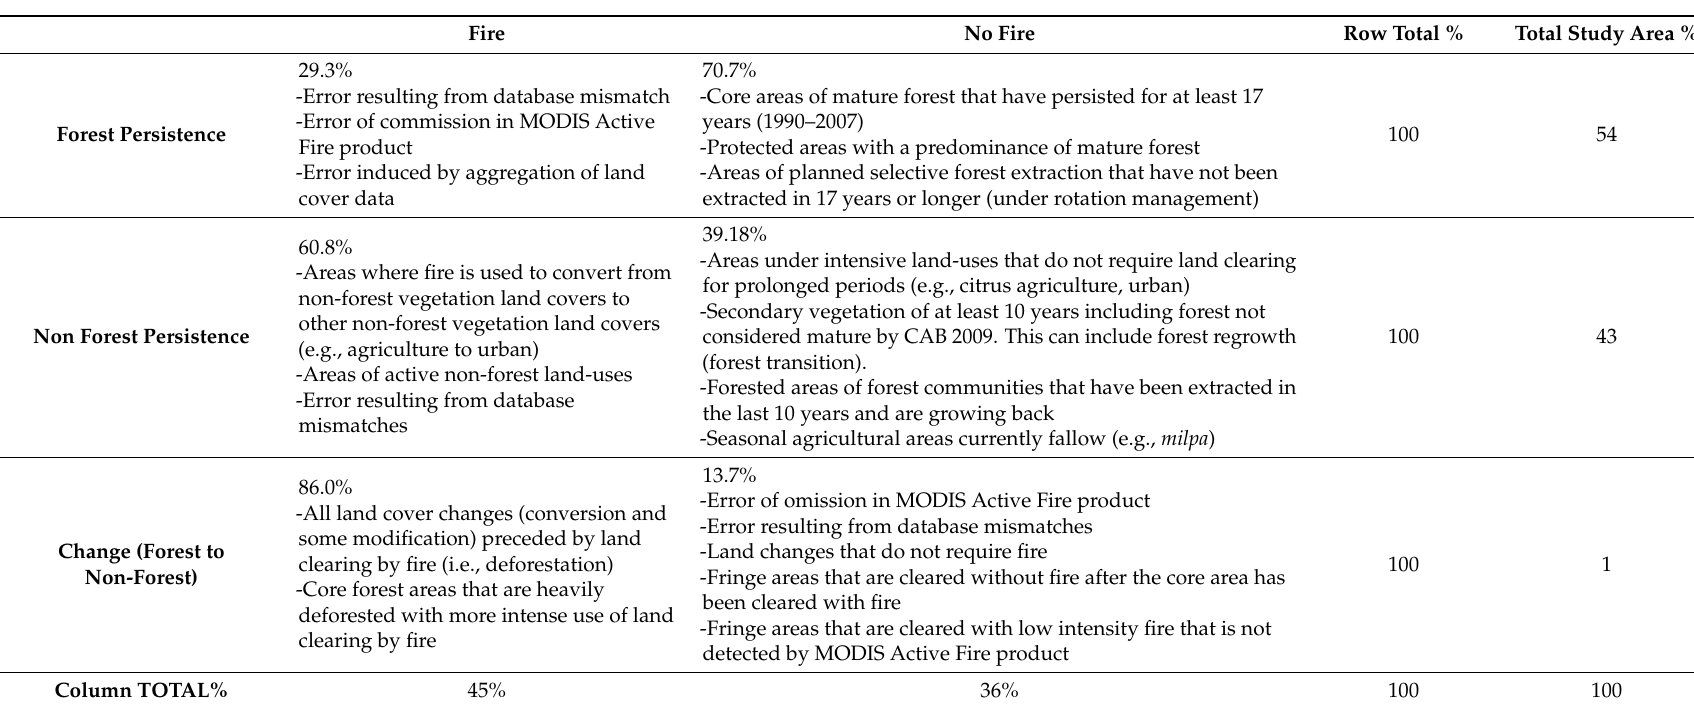
Table 1. Cross-tabulation of fire occurrence and land change/persistence: row, column and total percentages per class. Preliminary interpretation matrix (extended/detailed legend for Figure